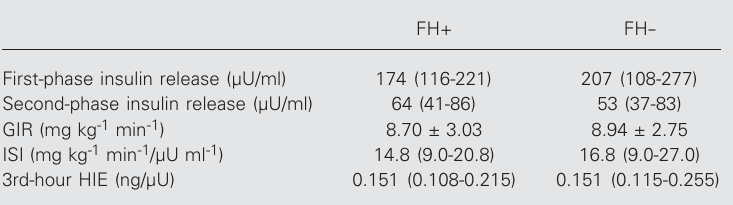
Table 2. Hyperglycemic clamp measurements of insulin secretion, insulin sensitivity, and hepatic insulin extraction of individuals with (FH+) and without (FH-) a first-degree relative with type 2